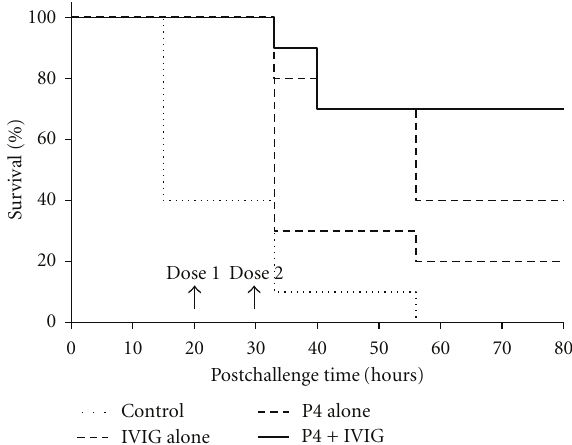
Figure 3: Survival of S. aureus -strainN-infected mice after P4- treatment. P4 with serotype-specific IgG confers protection to Swiss-Webster mice against intranasal S. aureus strainN challenge. Intravenous injection of P4 (100 μ g/mouse) with Gammaglobulin (100 μ L/mouse) at 15 and 24 hours after challenge provided highly significant protection (70%; P = 0 . 02) from S. aureus strainN infection (Kaplan-Meier